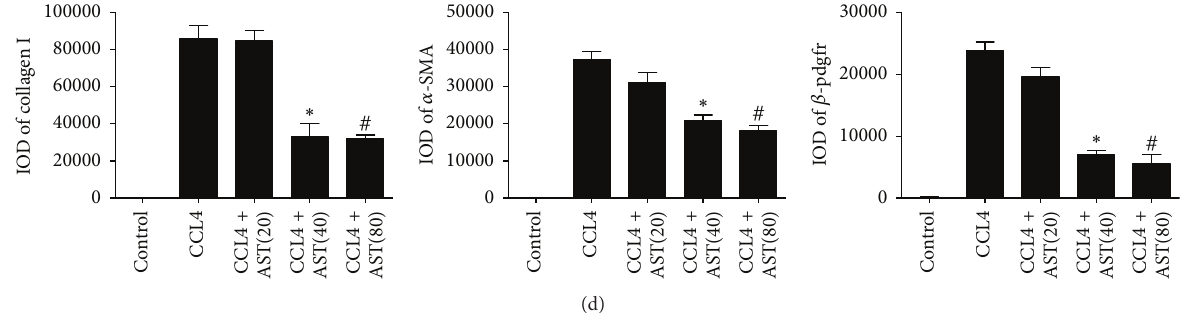
Figure 3: Effect of astaxanthin on the activation of HSCs. (a) The analysis of western blotting showed that astaxanthin obviously decreased the expression of 𝛼 -SMA, 𝛽 -pdfgr, and collagen I with the doses of 40 mg/kg and 80 mg/kg. (b) The mRNA levels of collagen I 𝛼 1, collagen I 𝛼 2, 𝛼 -SMA, and 𝛽 -pdgfr were significantly downregulated by astaxanthin (40 mg/kg and 80 mg/kg). Data are expressed as mean ± SD ( 𝑛 = 7 , ∗ 𝑃 < 0.05 for CCL4 + AST(40) versus CCL4, # 𝑃 < 0.05 for CCL4 + AST(80) versus CCL4). (c) The areas of positive cells of 𝛼 -SMA, 𝛽 -pdfgr, and collagen I were diminished by astaxanthin (40mg/kg and 80 mg/kg), showed by immunohistochemistry staining (original magnification: ×200 ). (d) The IODs of 𝛼 -SMA, 𝛽 -pdfgr, and collagen I were analyzed by Image-pro Plus 6.0. There existed a significant decrease with astaxanthin (40mg/kg and 80 mg/kg) treatment ( 𝑛 = 7 , ∗ 𝑃 < 0.05 for CCL4 + AST(40) versus CCL4, # 𝑃 < 0.05 for CCL4 + AST(80) versus